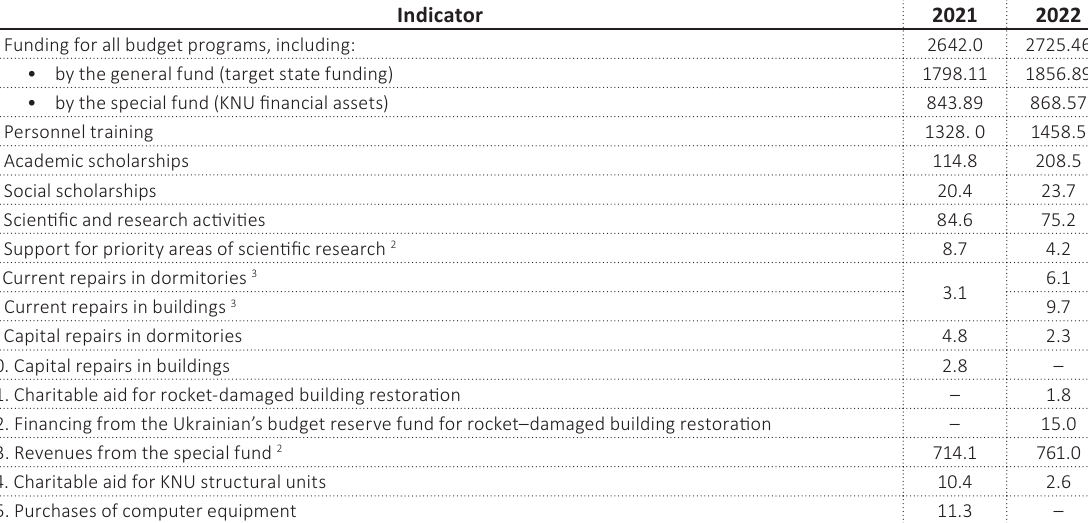
Table A2. KNU’s partial funding structure, in UAH million